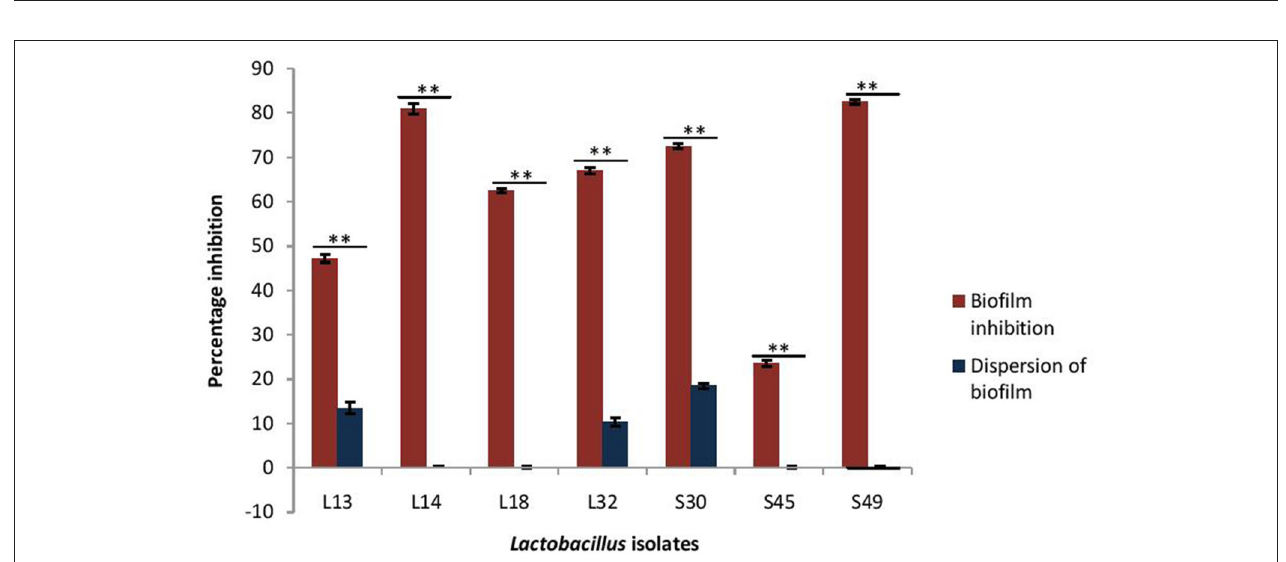
FIGURE 5 | Effect of CS of lactobacilli isolates on the biofilm formation and dispersion of 24h old performed biofilms of V. parahaemolyticus . Bars are representative of the means and error bars represent standard deviation of three independent experiments. **Significance ( p < 0.0001) was measured by using Student’s t